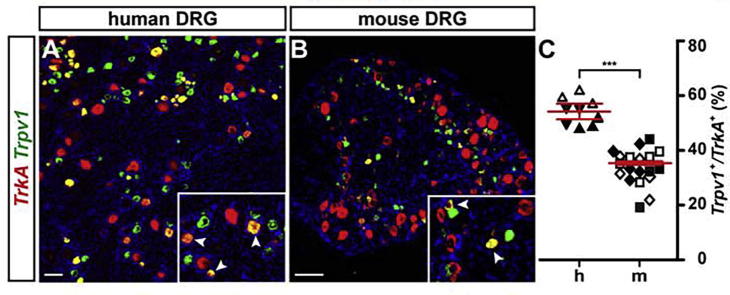
A higher percentage of TRPV1/TRKA1 positive neurons reside in human compared to mouse DRGs. (A, B) Dual-color fluorescence in situ hybridizations using probes to detect TrkA (red) and Trpv1 (green) in human (A) and mouse (B) DRG sections are shown. Inserts display close-ups with arrowheads indicating double-positive neurons. (C) Quantification of double-positive neurons in human (h) versus mouse (m) DRGs (expressed as percentage Trpv1 positive cells of all TrkA positive cells), showed a significant difference between the two species (linear effects model; data shown as mean ± SEM; p = 0.0003 ***). Differently oriented or shaded triangles indicate percentages found in DRG sections obtained from different human individuals (N = 3), differently oriented or shaded squares depict percentages found in sections obtained from different mice (N = 4); scale bar = 100 μm. (For interpretation of the references to color in this figure legend, the reader is referred to the web version of this article.)